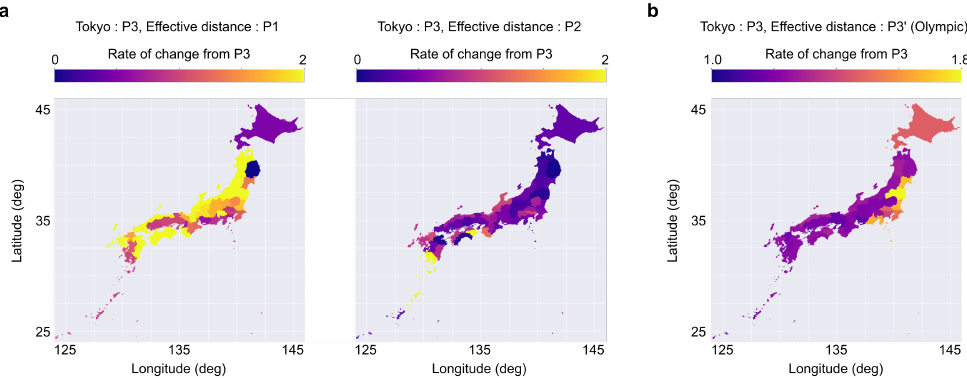
Figure 6. Simulations quantitatively estimating the effects of effective distance on a scale of the pandemic in each prefecture. ( a ) Estimated increase or decrease of total infection during an equivalent period as P3 when the effective distance from Tokyo is set to the same as P1 (left) or P2 (right) and the source (Tokyo) is the same as P3. ( b ) Estimated increase in infections of infection during an equivalent period as P3 when every prefecture approaches Tokyo because of a large-scale event such as the Olympics. Some prefectures where some games are held are closer to Tokyo than others. The results of the simulated shifts are shown in Figure